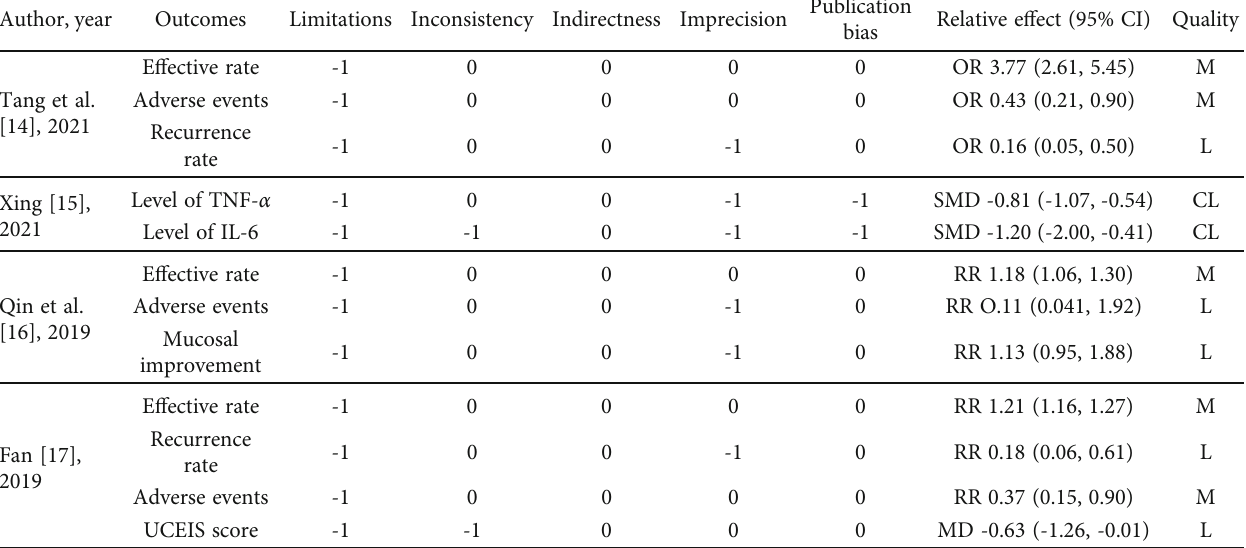
Table 5: Certainty of evidence